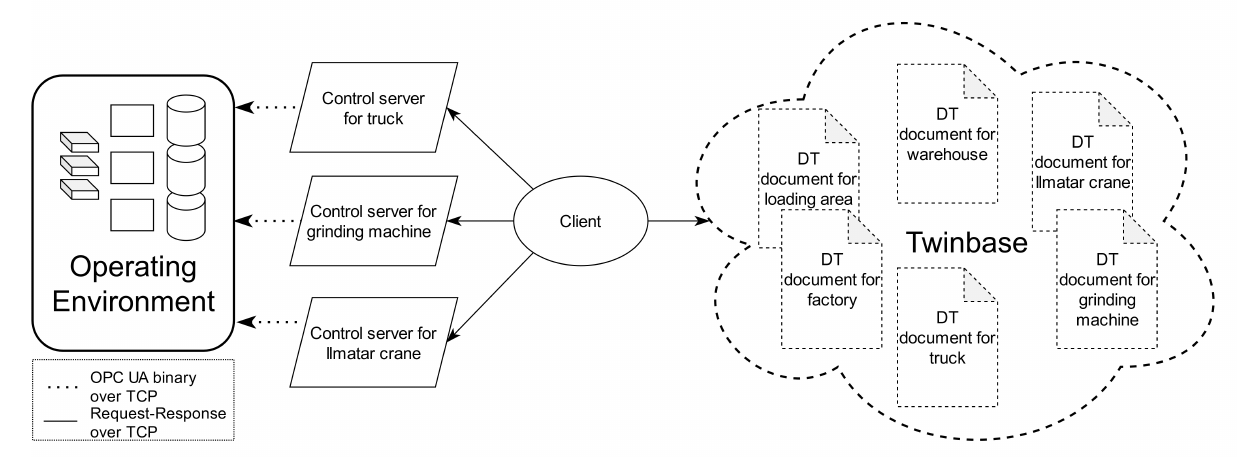
Figure 3. Centralized client-server control implementation corresponds to the traditional way of im- plementing factory communications. Twinbase use is voluntary in this architecture, and it can be integrated to be a part of the client. The arrows indicate the direction in which communication can be initiated, but data can still flow in both